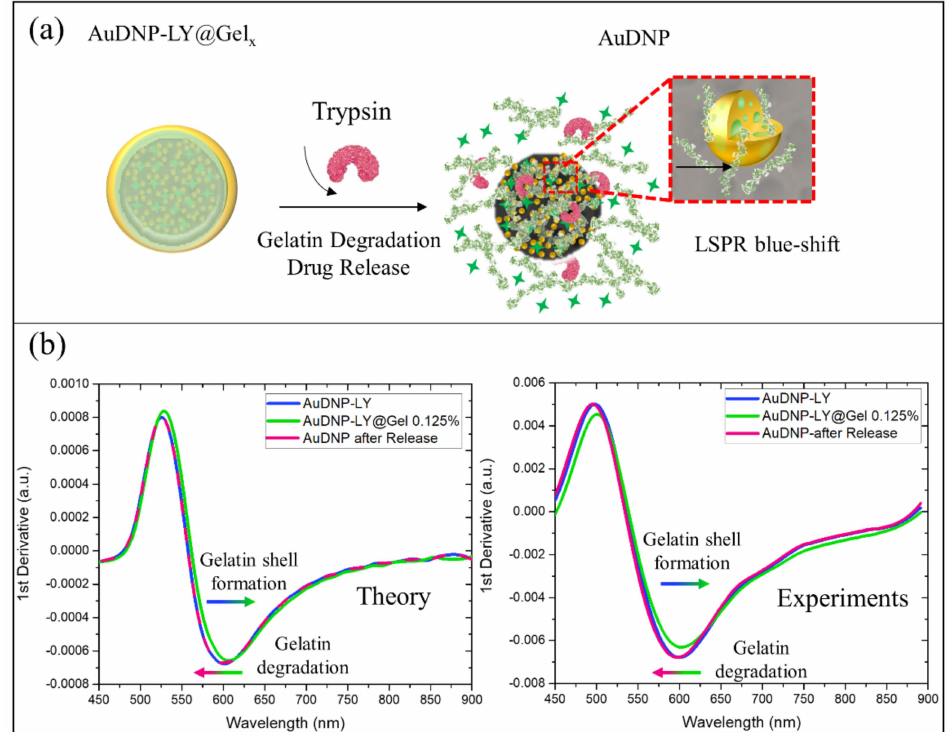
Figure 5. Gelatin degradation and drug release optical monitoring of AuDNP-LY@Gel 0.125% . ( a ) Schematization of the in-vitro gelatin degradation and drug release in a solution containing the trypsin enzyme. The scheme is not in scale and is not intended to represent the full sample composition. ( b ) Theoretical and experimental first derivatives of the absorption spectra of the AuDNP-LY system (blue lines), AuDNP-LY@Gel 0.125% (green lines), and after drug release test, during which gelatin degradation occurs (purple